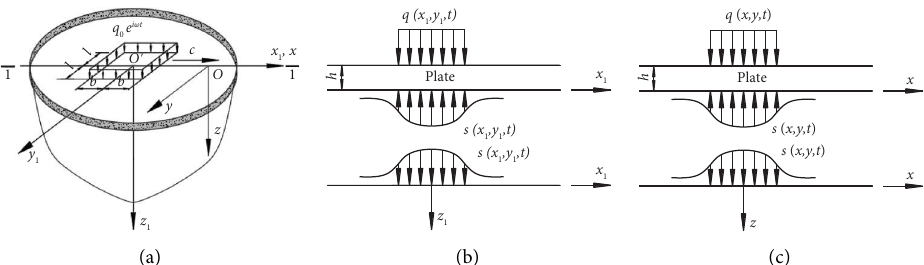
Figure 1: Mechanics model of elastic plate on orthogonal anisotropic saturated foundations. (a) Mechanical model. (b) 1-1. (c) Coordinate